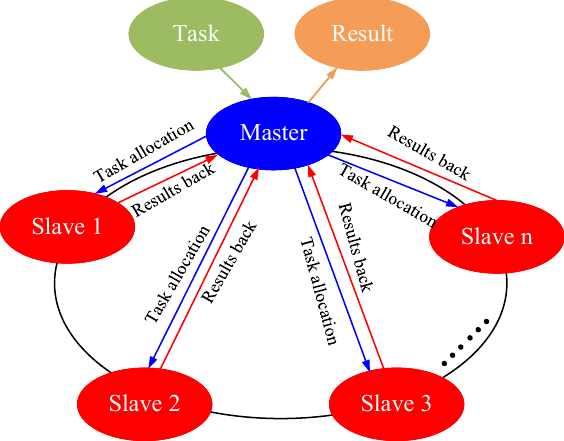
Figure 2. Flowchart of the parallel FEM solver.